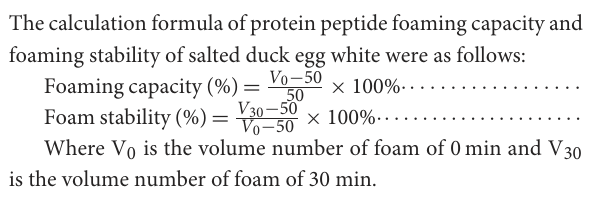
table. After coating with an ion sputtering apparatus